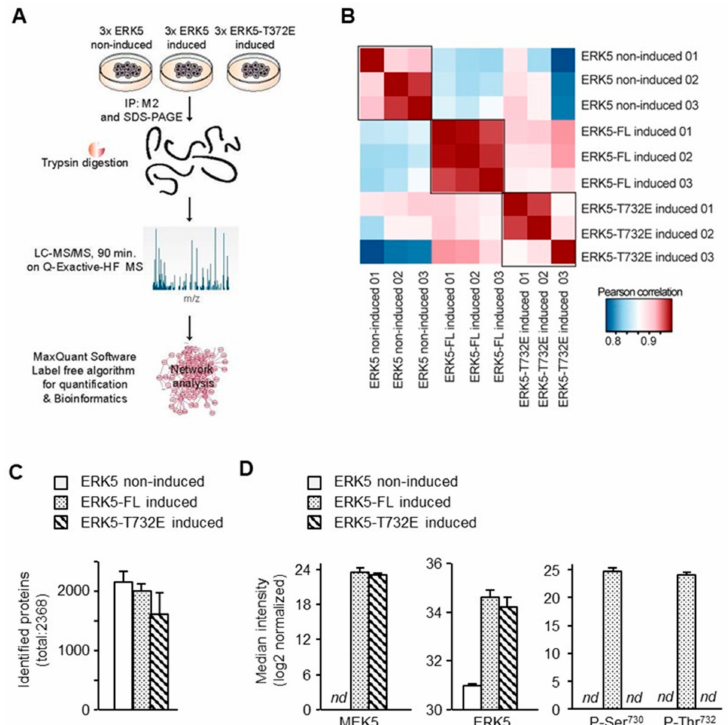
Figure 5. Quantitative mass spectrometry analysis of M2 immunecomplexes. ( A ) Illustration of the workflow to analyze the interactomes of non-induced, ERK5-FL and ERK5-T732E pull downs. Recombinant Flp-In HeLa cell lines were lysed in RIPA bu ff er 24 h after tetracycline induction. Mock treated cells with DMSO were utilized as non-induced controls. ( B ) Pearson correlation coe ffi cients demonstrating the reproducibility of pull downs analyzed by mass spectrometry in the di ff erent conditions. ( C ) Quantification of mean total number of proteins in each pull down. ( D ) Signal intensitiesofMEK5andERK5proteins, andphosphorylatedSer 730 andThr 732 residues, detectedbymass spectrometry in the non-induced and induced ERK5-FL, or ERK5-T732E precipitates. The data represent the median normalized intensity values ± SD of three independent experiments. nd indicates that the protein or the phosphorylated residue was not-detectable in the corresponding